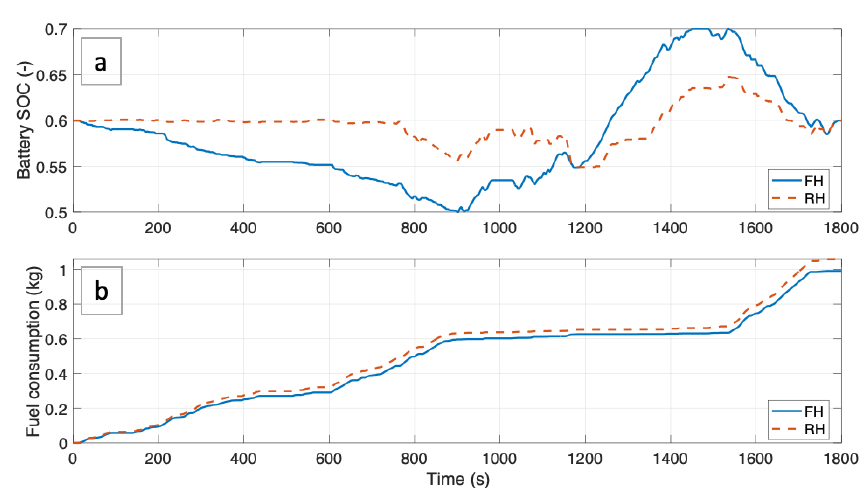
Figure 5. Comparison of battery optimal SOC time behavior ( a ) and fuel consumption trend ( b ) achieved with RH approach with a H p window of 300 s and a H s window of 150 s (red dashed lines) with respect to those achieved with the FH approach (solid blue lines) applied to a WLTC cycle (see Figure 4).